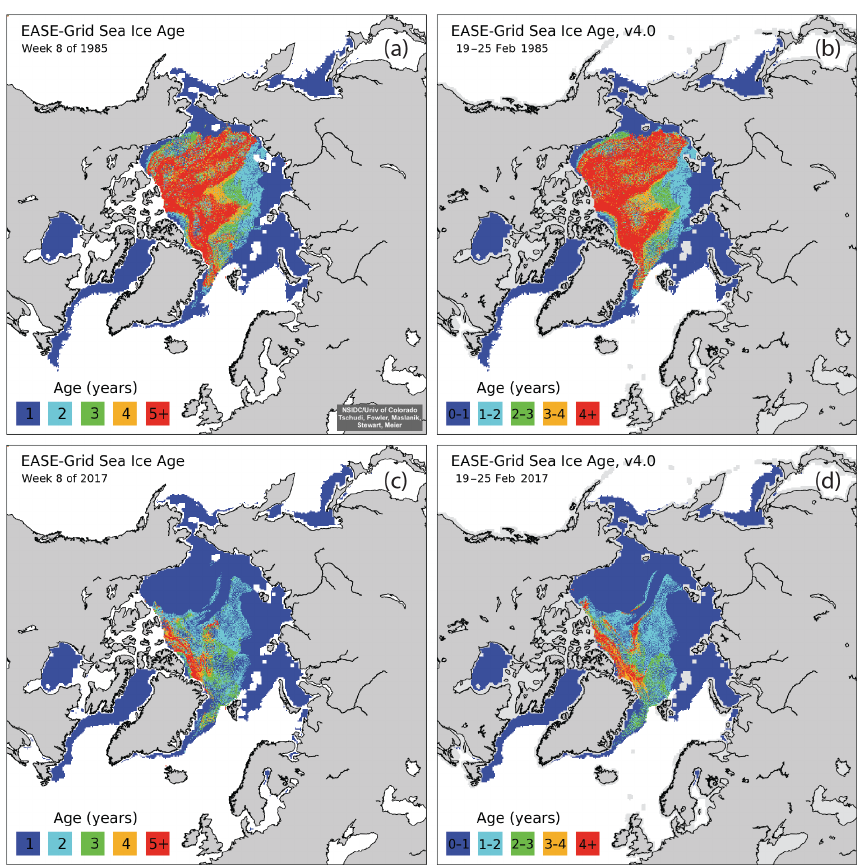
Figure 6. Comparison of Week 8 (19–25 February) ice ages for 1985, (a) Version 3 and (b) Version 4, and for 2017, (c) Version 3 and (d) Version